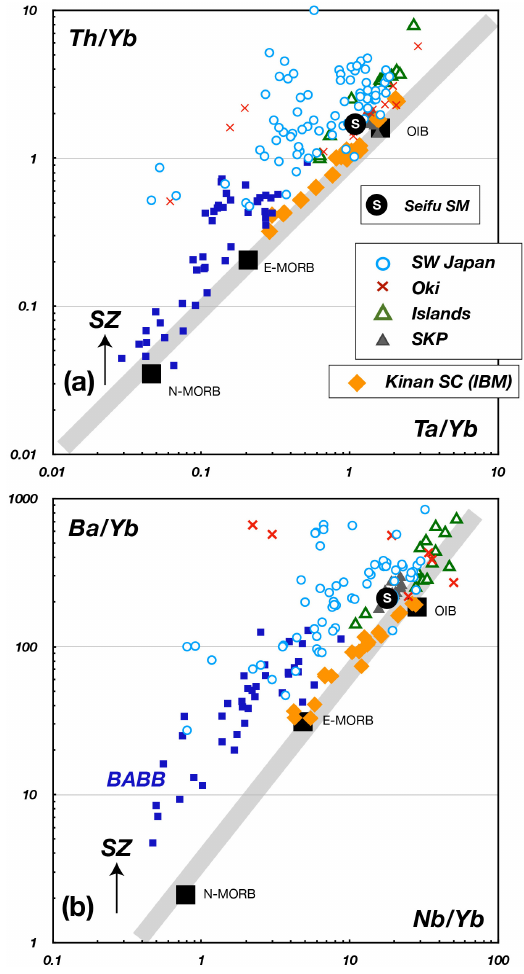
Figure 9. (a) Th / Yb vs. Ta / Yb. (b) Ba / Yb vs. Nb / Yb. The gray line represents the array of global MORB compositions, and the arrow indicates the effect of subduction components (SZ) (Pearce and Stern, 2006). Compositions of N-MORB, E-MORB, and OIB are from Sun and McDonough